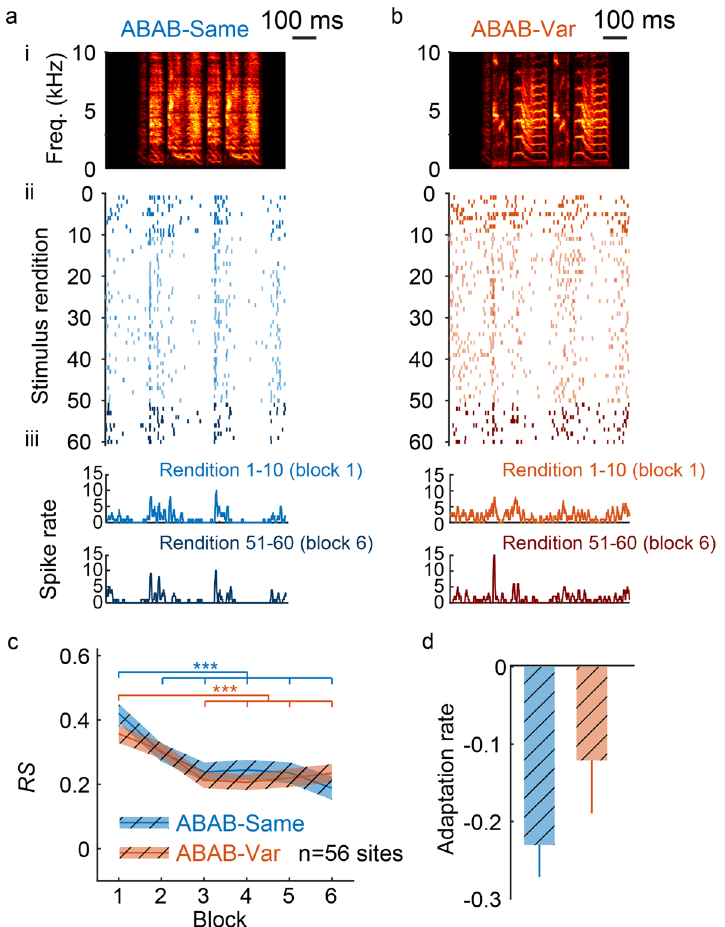
Figure 2. Auditory responses to 60 repetitions of a single sequence (ABAB-Same series) and to 60 sequence variants (ABAB-Var series) in awake birds. Responses of a representative unit to the ABAB-Same ( a ) and the ABAB-Var ( b ) series used as auditory stimuli. Neuronal responses that are time-aligned with sequence spectrograms (ai and bi: the sequence repeated 60 times for the ABAB-Same example series and one sequence variant for the ABAB-Var example series) are shown as raster plots (aii and bii, 60 iterations, dark colors for the 10 first and 10 last trials) and peristimulus time histograms (aiii and biii; 10 ms bin width; for the 10 first (top) and the 10 last (bottom) trials). ( c ) Modulation of responses over the six successive blocks of ten trials (each block for the ABAB-Var series includes 10 variants of the auditory sequence). The RS values estimated the strength of the responses driven by the series used as auditory stimulus. Thick line indicates mean responses for the population of recording sites (n = 56). Hatched area represents SEM. ( d ) Adaptation rate (mean ± SEM) of responses computed over the 10 first trials did not significantly differ between the two